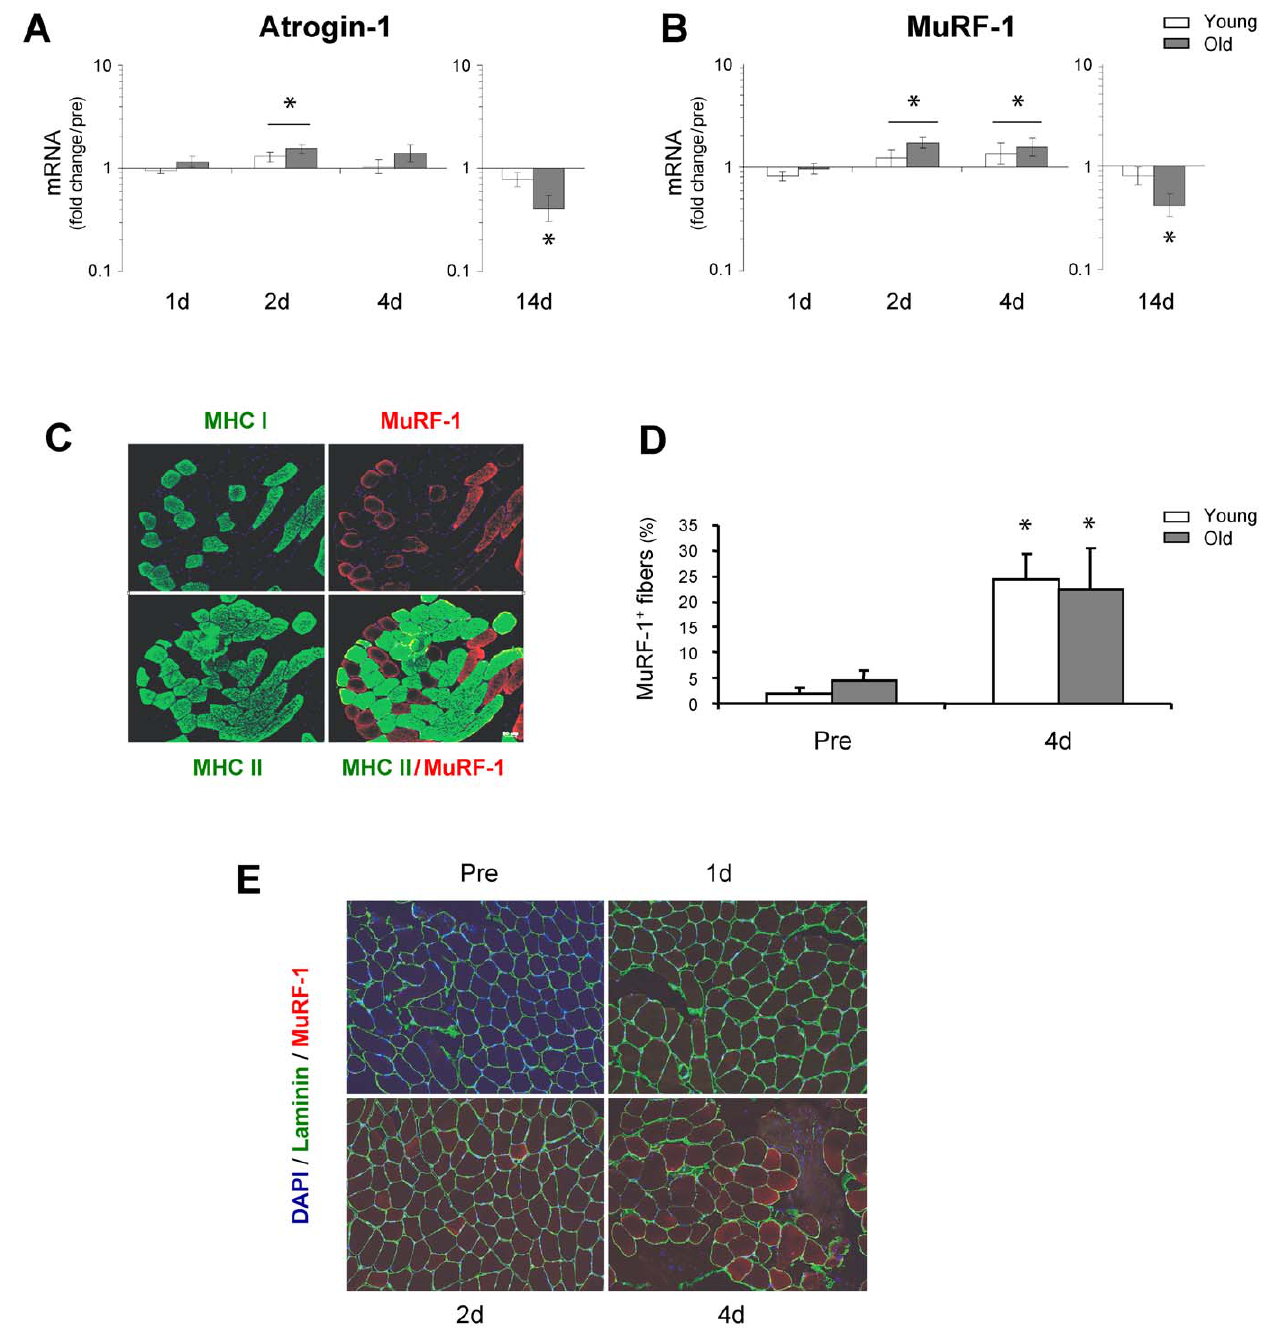
Figure 2. Immobility results in an increase in the transcriptional status and immunodetection of Atrogin-1 and MuRF-1 in the early phase of disuse muscle atrophy. A & B . The mRNA level of Atrogin-1 and MuRF-1 was determined using qRT-PCR and significant increases were found in the early phase (2–4 days) of immobility, in both young and old skeletal muscle. At the later time-point (14 d) Atrogin-1 and MuRF-1 expression levels decreased in aged muscle, whereas the expression levels of Atrogin-1 and MuRF-1 mRNA were unchanged from baseline in young muscle. Data are geometric means 6 back-transformed SEM. C . Immunodetection of DAPI (blue), and MuRF-1 (red) are shown for 10 m m skeletal muscle cryosections. Potential muscle fiber specificity was analyzed by simultaneous incubation of primary antibodies for MuRF-1 mixed with either anti-skeletal Myosin-Fast or anti-skeletal Myosin-Slow (green), demonstrating an almost 100% affinity of MuRF-1 for type 1 muscle fibers. D . Total numbers of MuRF-1 positive myofibers were quantified for both young and old muscle and a significant increase was detected in the number of MuRF-1 positive fibers after 4 days of immobility. * Time effect, p , 0.05 compared to pre. * Time effect, p , 0.05 bar indicates young and old combined compared to pre. Data are means 6 SEM. E . Immunodetection of DAPI (blue), Laminin (green) and MuRF-1 (red) are shown for 10 m m skeletal muscle cryosections at pre, 1 d, 2 d and 4 d of immobilization.